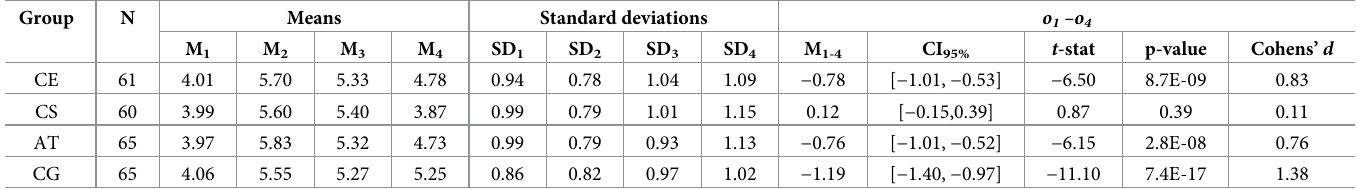
Table 1. Opinion means and standard deviations at each measurement time and t-tests for the differences o 1 – o 4 for the debiasing treatment groups.